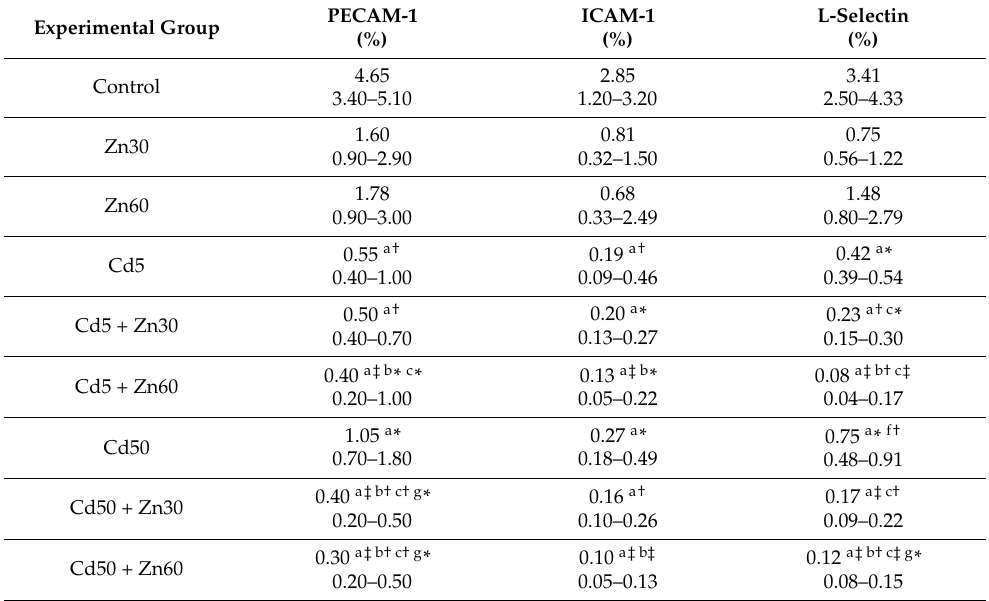
Table 6. The expression of PECAM-1, ICAM-1, and L-selectin on the endothelial cells of the abdominal aorta in particular experimental groups 2 .